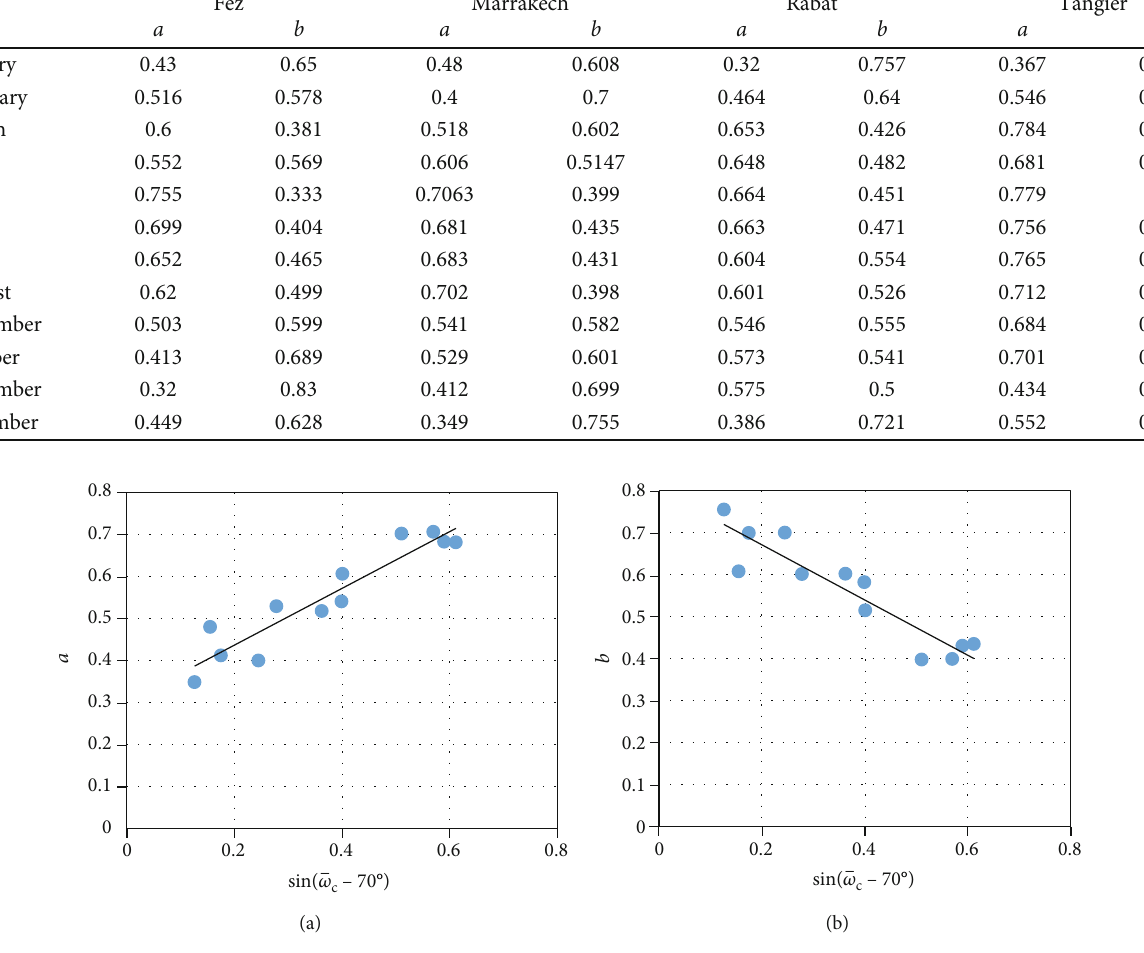
Figure 2: Example of the presentation of a and b as a function of sin ð ω